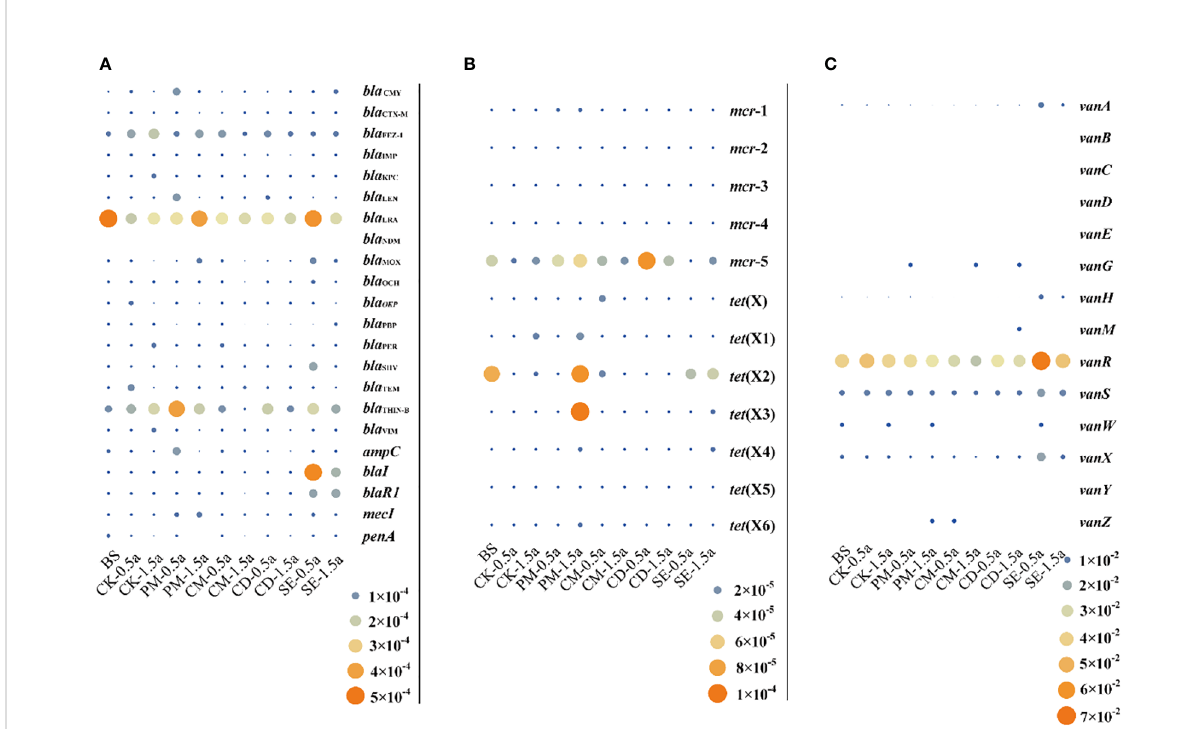
FIGURE 2 Bubble graph showing the relative abundance of clinically critical antibiotic resistance genes. (A) Relative abundance of extended-spectrum beta-lactamase and carbapenemase genes. (B) Relative abundance of mobilized colistin resistance genes and tigecycline resistance genes. (C) Relative abundance of vancomycin resistance